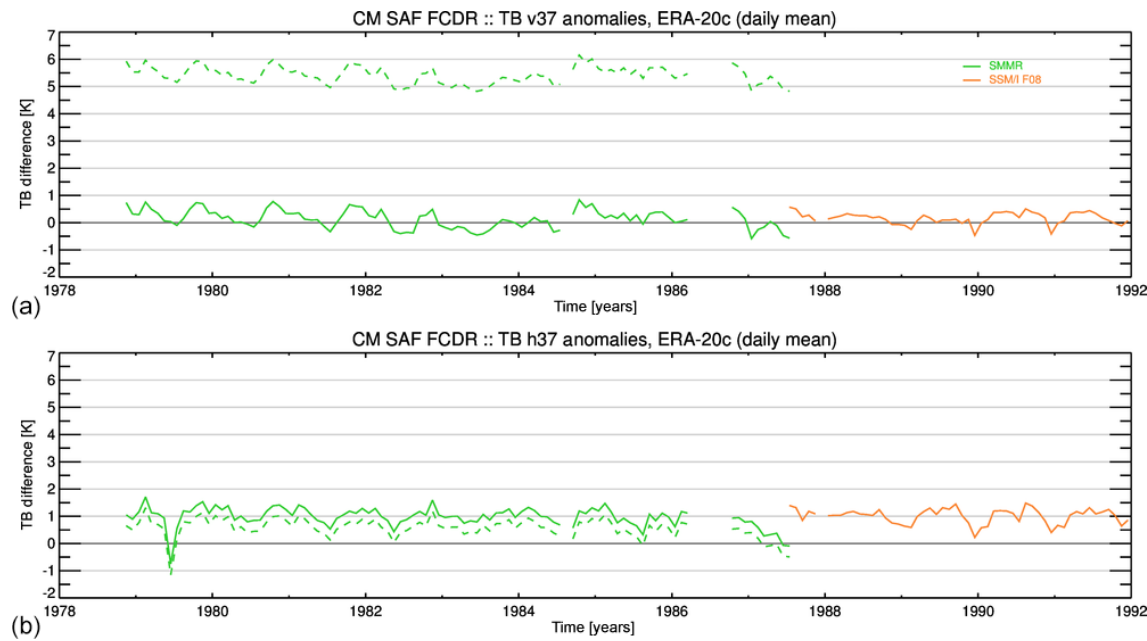
Figure 9. Time series of global monthly mean differences between observed and modelled T B values at 37GHz, v-pol (a) and 37GHz, h-pol (b) before (dashed lines) and after (solid lines) inter-calibration of SMMR (SMMR, green; F08, orange).